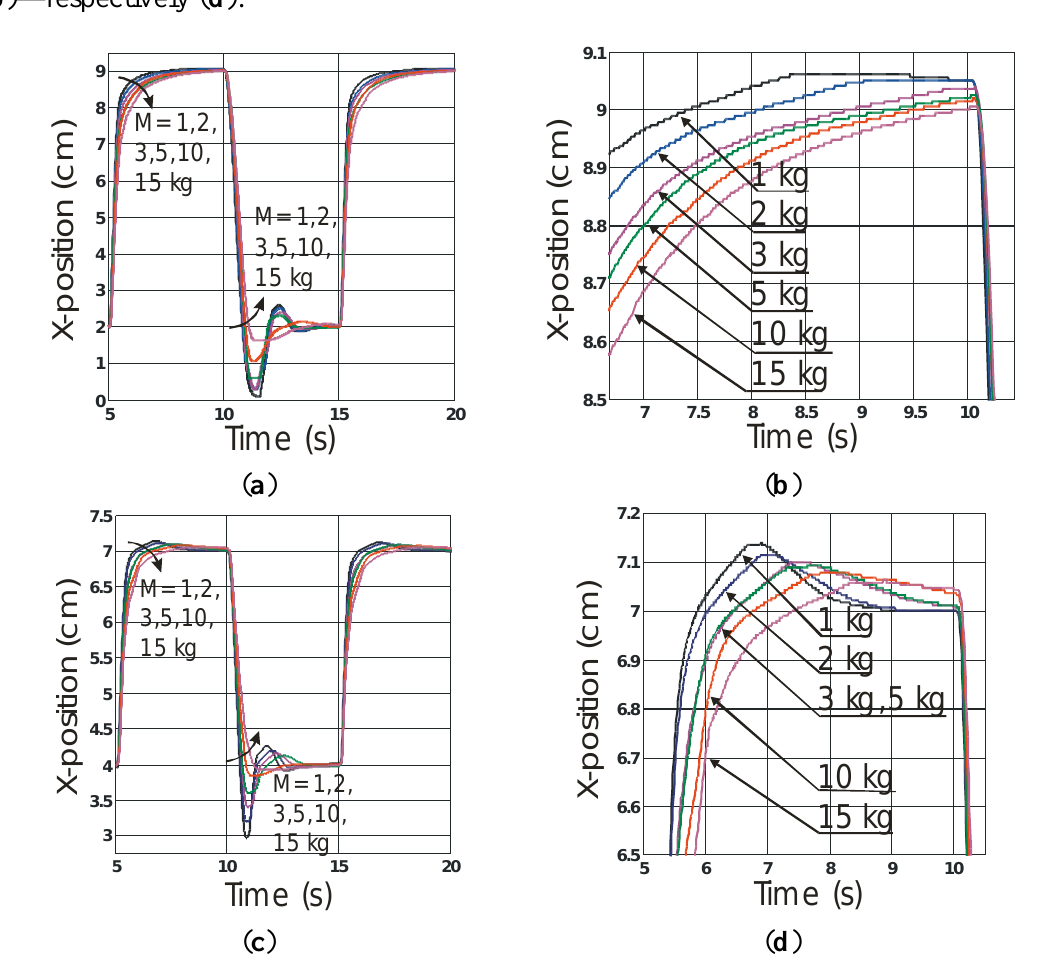
Figure 6. Step responses performed by our rayon yarns McKibben muscle driving various loads: ―long‖ ( a )—respectively ―short‖ ( c )—step with close-up of final convergence ( b )—respectively ( d ).